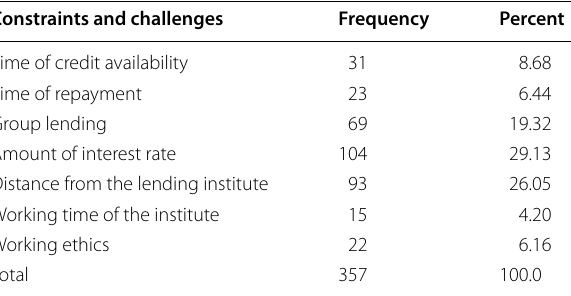
Table 8 Challenges of the respondents to access service. Source :